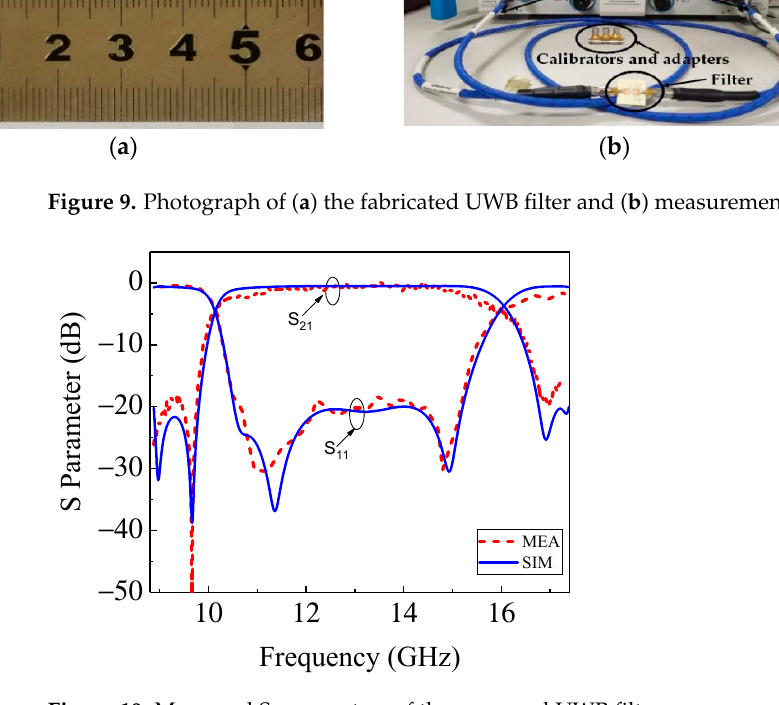
Figure 10. Measured S parameters of the proposed UWB filter.